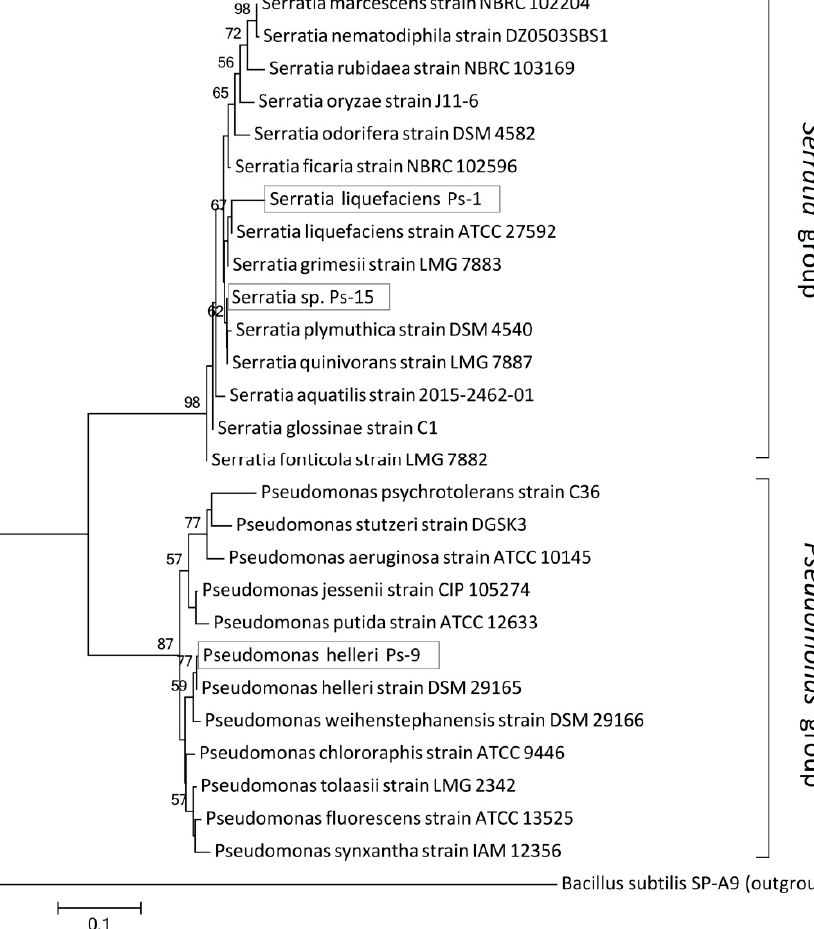
Table 1. Antagonistic properties of isolated bacteria strains tested against Fusarium spp. cultures. Pathogen